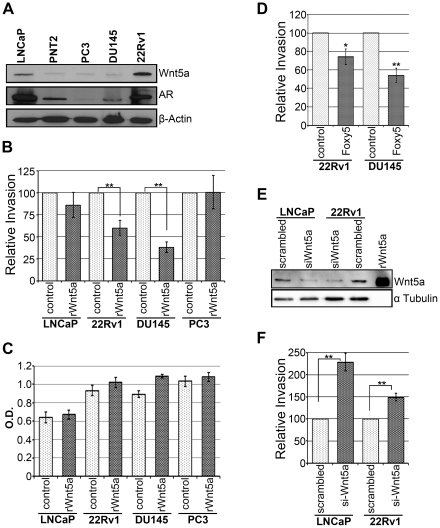
Analysis of Wnt5a protein expression in different prostate cell lines and its effect on PCa cell invasiveness and proliferation.
A) This panel shows the endogenous Wnt5a and AR expression in four indicated PCa cell lines (LNCaP, 22Rv1, DU145 and PC3 cells) and in one immortalized human prostate epithelial cell line (PNT2 cells). Wnt5a protein band was identified by running rWnt5a in parallel on the same gel. The blots were reprobed for β-actin as loading control. The presented blots are representative of 4 separate experiments. B) The panel outlines the relative invasion of LNCaP, 22Rv1, DU145 and PC3 cell lines after 24 h in the absence or presence of rWnt5a (0.4 µg/ml) in the assay described in the Materials and Methods section. The results are given as means ± SEM from 5 separate experiments. The differences in invasion between cells treated with vehicle alone or with rWnt5a were evaluated for statistical significance (p = 0.0001 for 22Rv1 and p<0.0001 for DU145). C) The panel outlines the proliferation of LNCaP, 22Rv1, DU145 and PC3 cell lines after 24 h in the absence or presence of rWnt5a (0.4 µg/ml). The results are given as means ± SEM from 5 separate experiments. There were no significant differences in proliferation between control and rWnt5a treated cells. D) The panel represents the relative invasion of 22Rv1 and DU145 cells after 24 h in the absence or presence of Foxy5 (100 µM) using the same assay as in panel B. The differences in invasion between cells treated with vehicle alone or with Foxy5 were evaluated for statistical significance (p = 0.01 for 22Rv1 and p = 0.0003 for DU145). E) The panel depicts the effects of siRNA knockdown of Wnt5a in LNCaP and 22Rv1. The blots were reprobed for α-tubulin as loading control. The presented blots are representative of 4 separate experiments. F) The panel outlines the relative invasion of LNCaP and 22Rv1 cells after treatment with Wnt5a si-RNA (Wnt5a knockdown) or scrambled siRNA (control), in the same assay previously used in panel B. The results are given as means ± SEM from 5 separate experiments. The difference in invasion between scrambled and si-Wnt5a knocked down cells were statistically significant for both cell lines (p<0.0001).